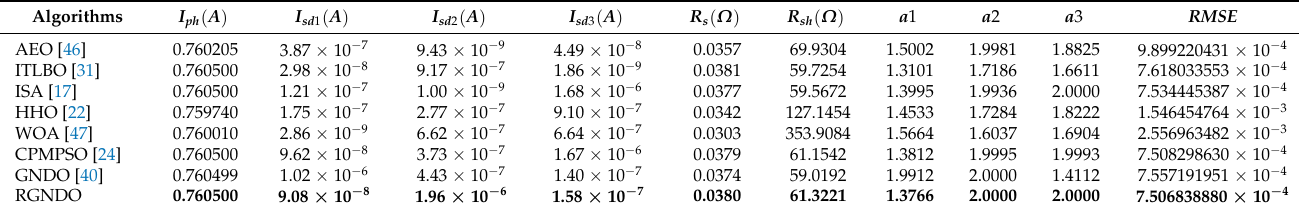
Table 5. Comparison according to the best RMSE and its corresponding parameter on RTC France.